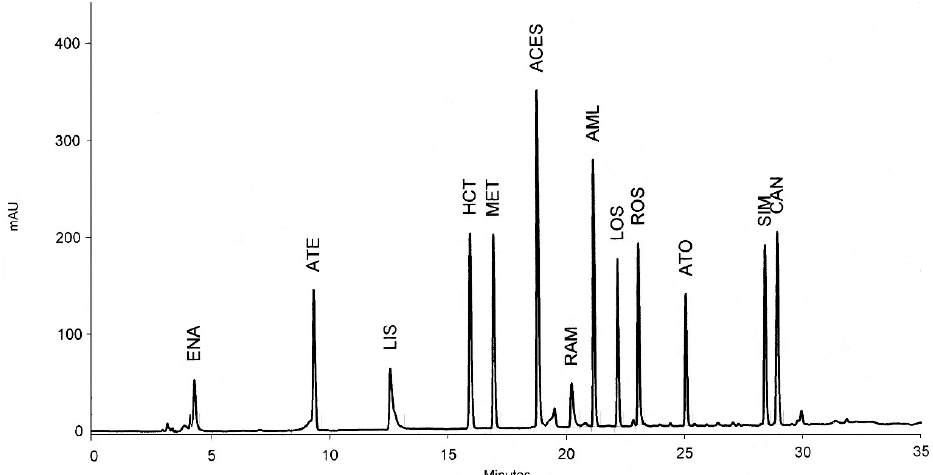
Figure 2. HPLC-DAD chromatogram of system suitability of 13 examined drugs obtained under the developed conditions. Table 4. Calibration curves equations and statistical tests used for linearity assessment and LOD and LOQ of the